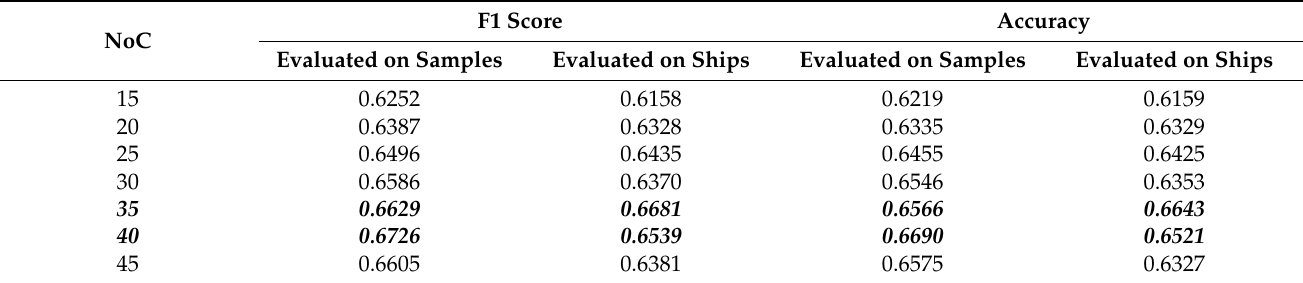
Table 10. Unit number in the hidden